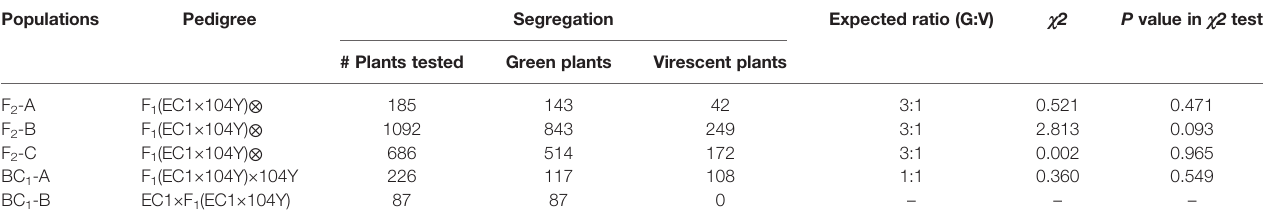
TABLE 1 | Segregation of plant leaf color in F 2 and BC 1 populations.